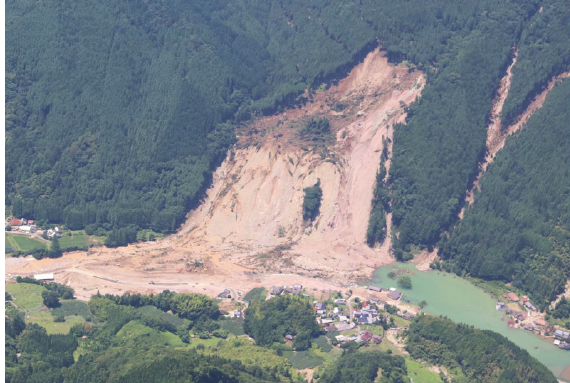
Figure 19. Sediment disasters in Hita City (2).